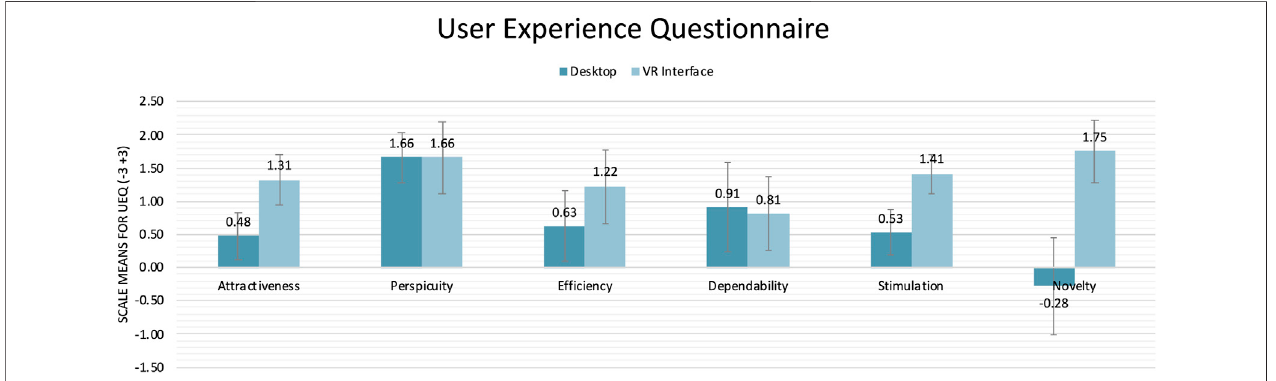
FIGURE 11 | Responses to the User Experience Questionnaire (Hart (2006)). Differences in attractiveness ( p -value (cid:2) 0.0072), stimulation ( p -value (cid:2) 0.0019) and novelty ( p -value (cid:2) 0.0007) are found to be signi fi cant different using a paired t-test.